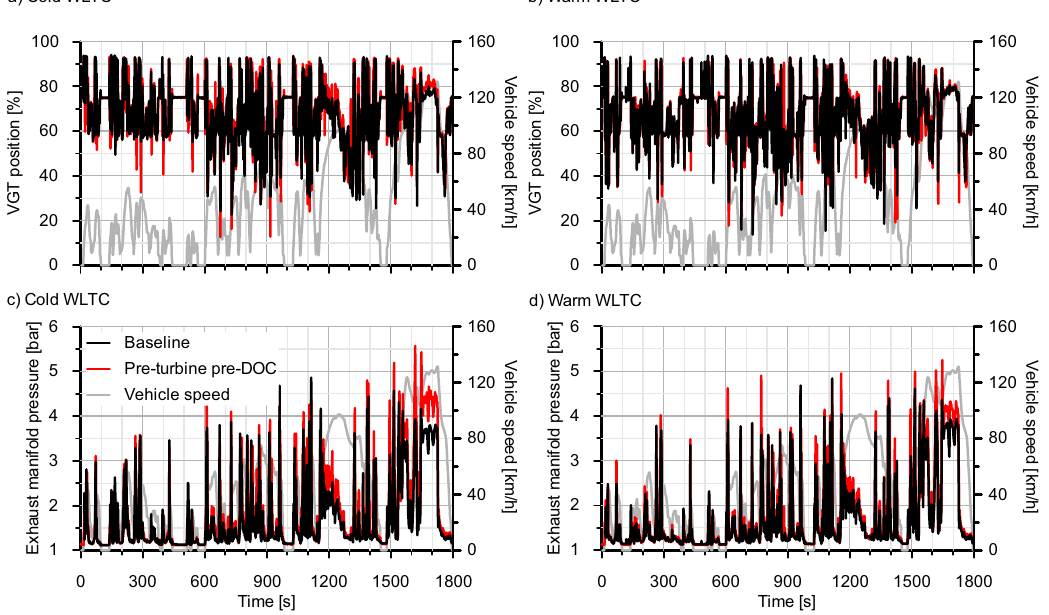
Figure 5. Exhaust manifold pressure and VGT position in cold and warm WLTCs with baseline ATS and pre-turbine pre-DOC configurations. ( a ) VGT position in cold WLTC, ( b ) VGT position in warm WLTC, ( c ) exhaust manifold pressure in cold WLTC, ( d ) exhaust manifold pressure in warm